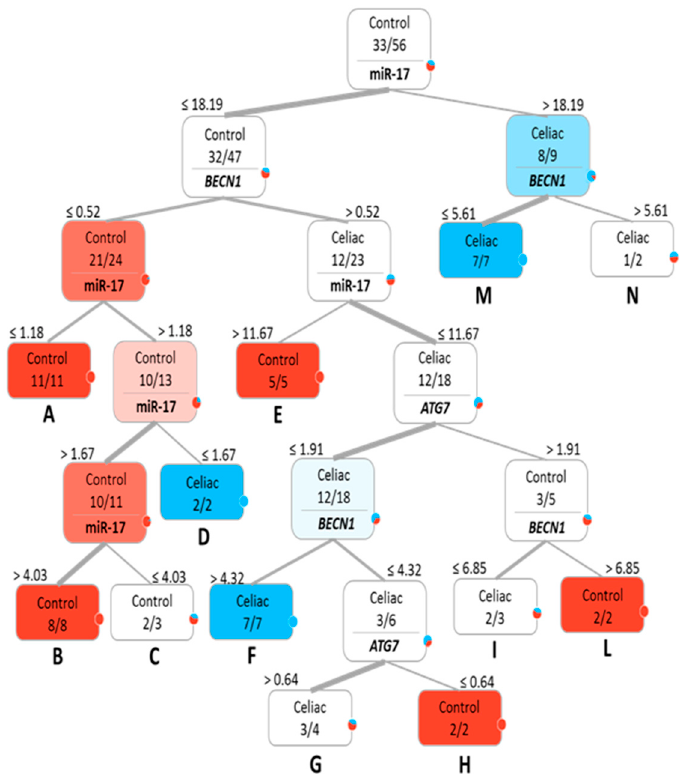
Figure 2. Classification tree obtained using the relative quantitative expression values (numbers over each box) of the analyzed genes ( ATG7 and BECN1 ) and miRNAs (miR-17 and miR-30a) in blood. CD patients are indicated in blue, controls in red. Color tonalities are related to the composition of each subgroup. Resulting subgroups are highlighted by capital letters.